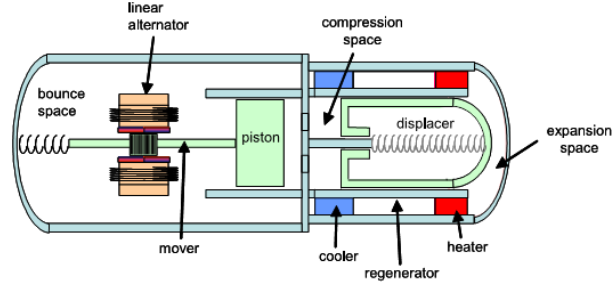
Figure 1. Cross-section schematic of an FPSPC.